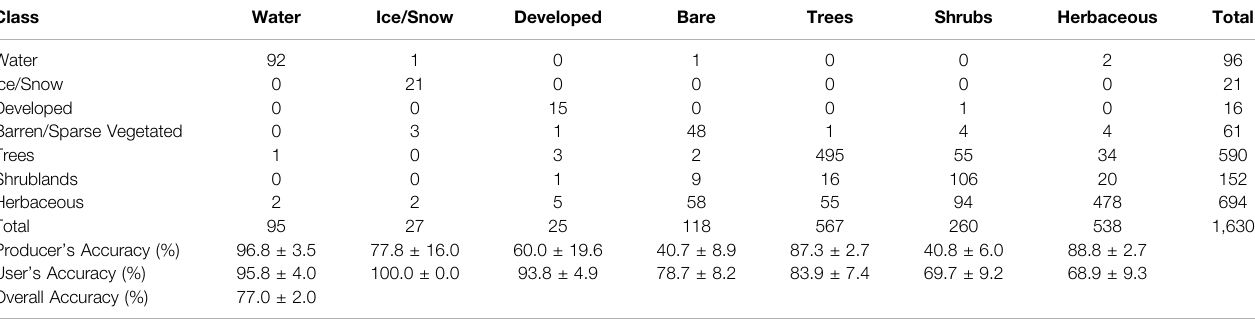
TABLE 4 | Confusion matrix and user and producer accuracies for the V1.0 GLanCE land cover product based on 1,630 reference points in North America. Class